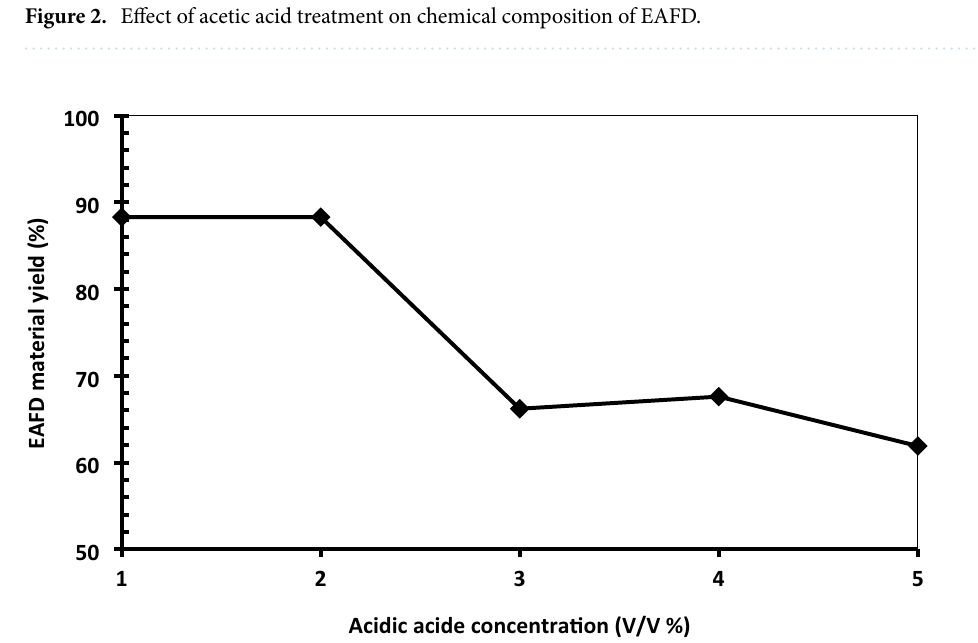
Figure 3. EAFD yield for the treated samples with different concentrations of acetic